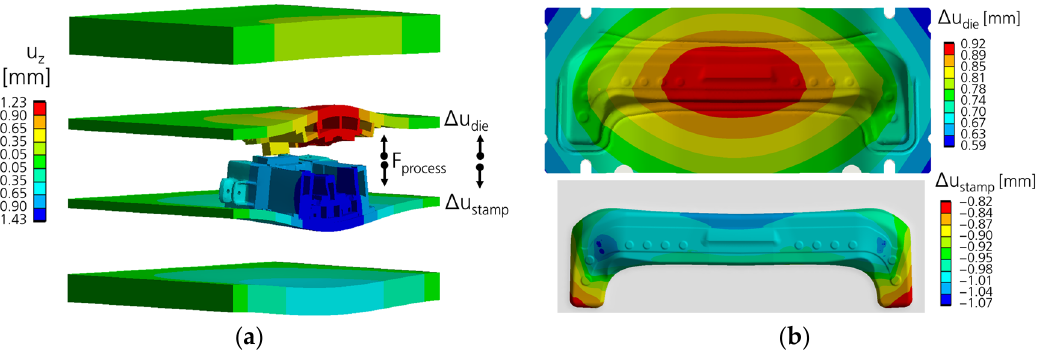
Figure 7. ( a ) Displacement of forming tool and reduced model of press table and ram (4-point hydraulic press) due to applied forming process pressure distribution on both sides of the active surfaces in contact with the metal sheet; ( b ) detailed displacement of active surfaces of die and stamp including press elasticity.